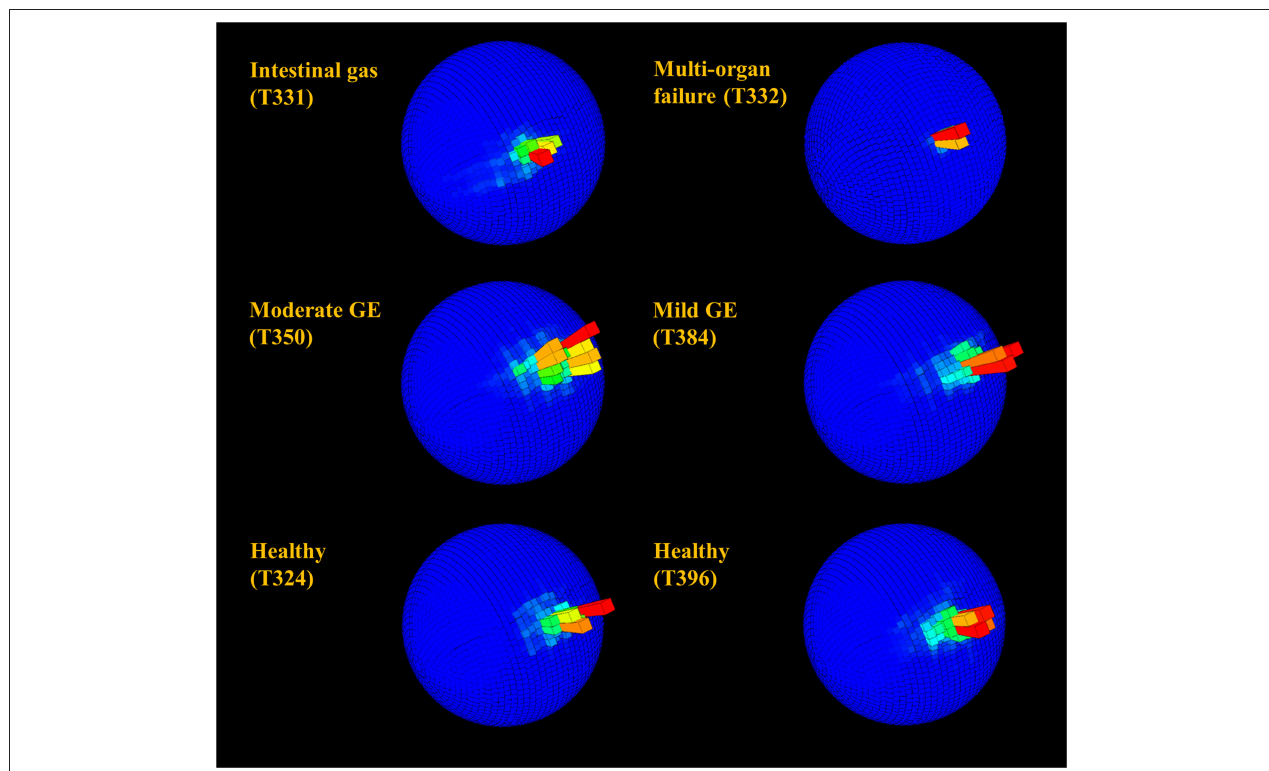
FIGURE 6 | Spherical histograms showing relative time (bar height and color; the mode is shown in red) over 24h allocated to body pitch and roll (see Wilson et al., 2016 for more detail) in rehabilitating turtles. Individuals in rehabilitation are identified by number (see Table 1 ) and suffered from various diseases including gas emboli (GE). Despite the superficial semblance of plots, very infirm individuals (in particular T332) with reduced activity generally occupied a small area of the sphere relative to healthy turtles, whereas individuals with mild to moderate GE generally occupied a slightly greater